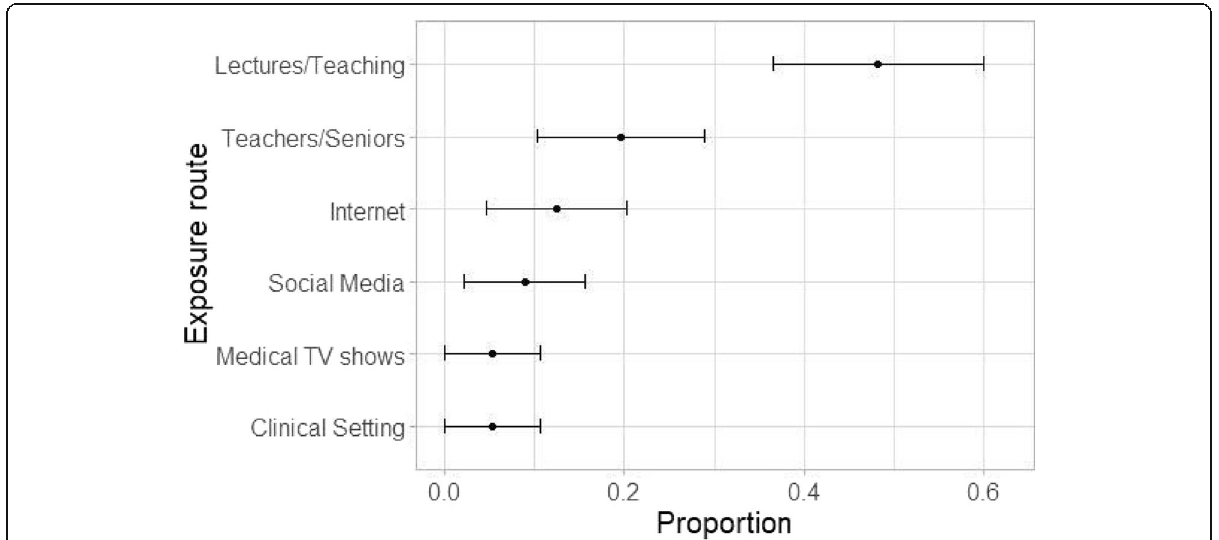
Fig. 3 N = 59. Response of students to survey question ‘ How were you first exposed to IR? ’ . Most students attribute awareness of IR through